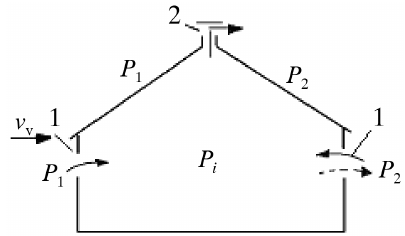
Fig. 1. Schematic view of animal shed with inlet